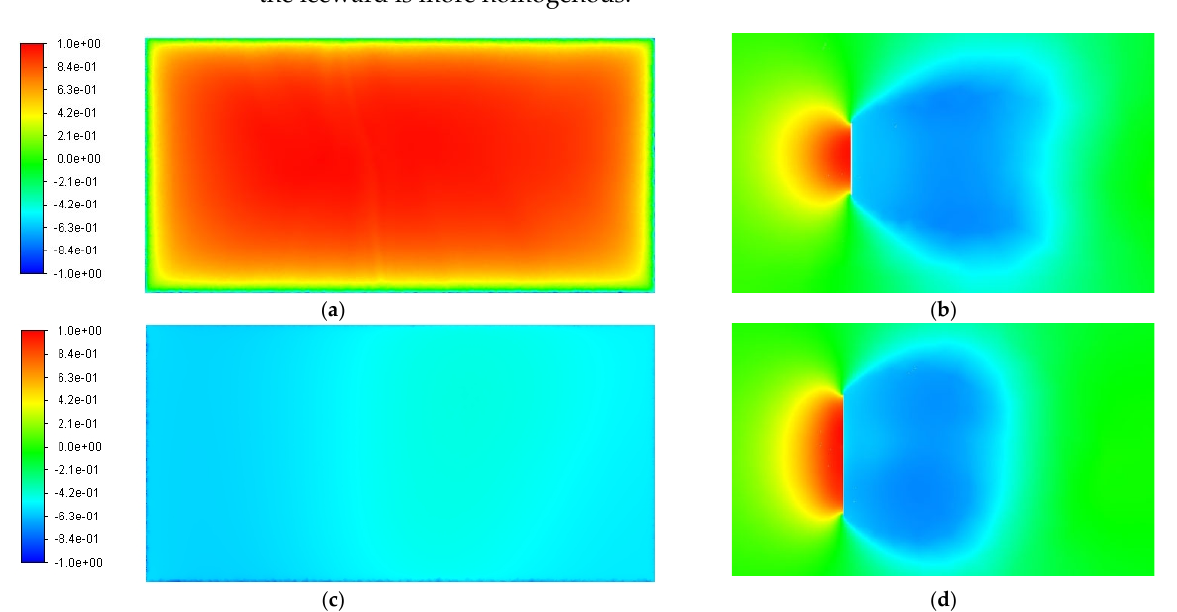
Figure 2. Contours of pressure coefficients on the windward face for ( a ) 28 staggered holes, ( b ) 200 uniform square holes, ( c ) 10 rectangular slots, and ( d ) curved